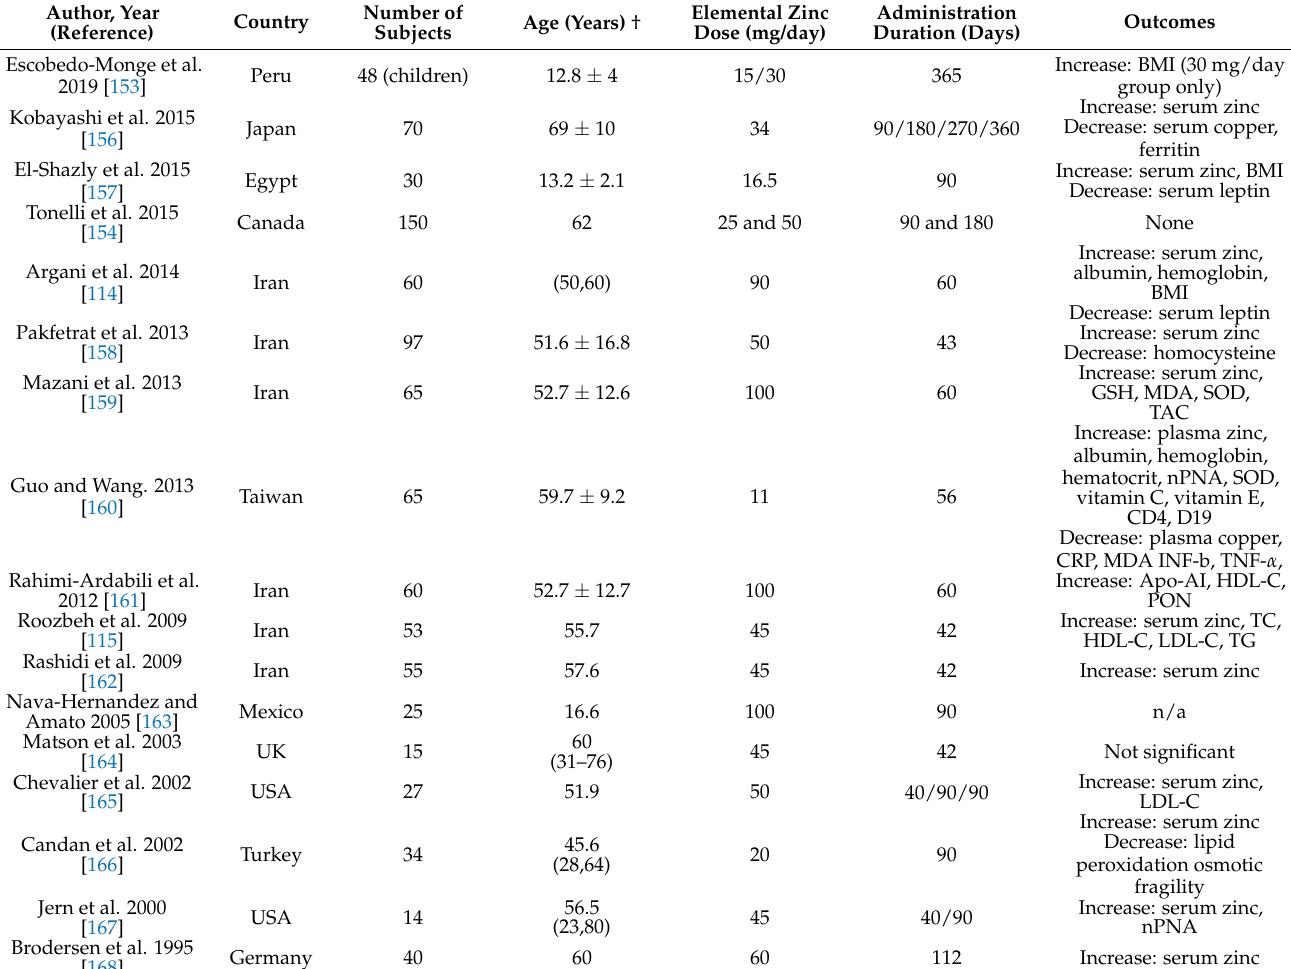
Table 4. Summary of RCTs of zinc supplementation in patients with